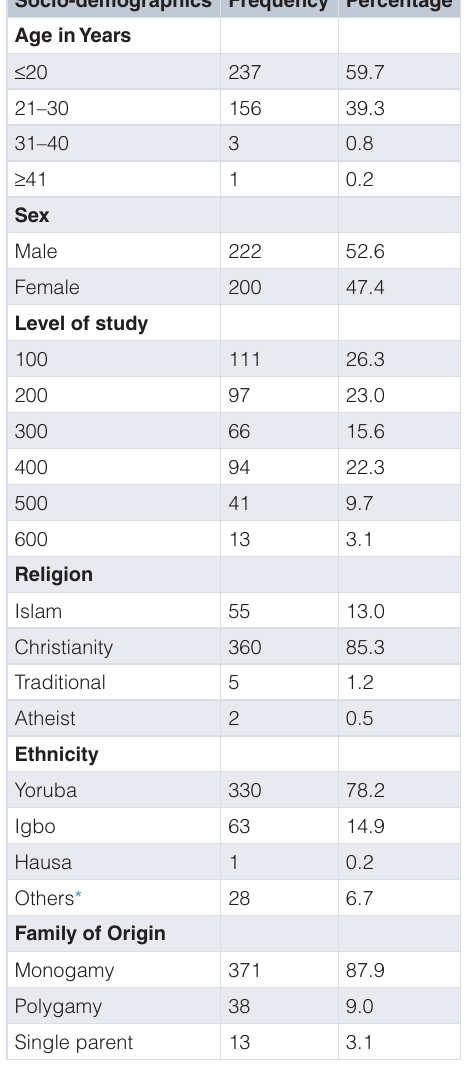
Table 1. Socio-demographic characteristics of respondents.